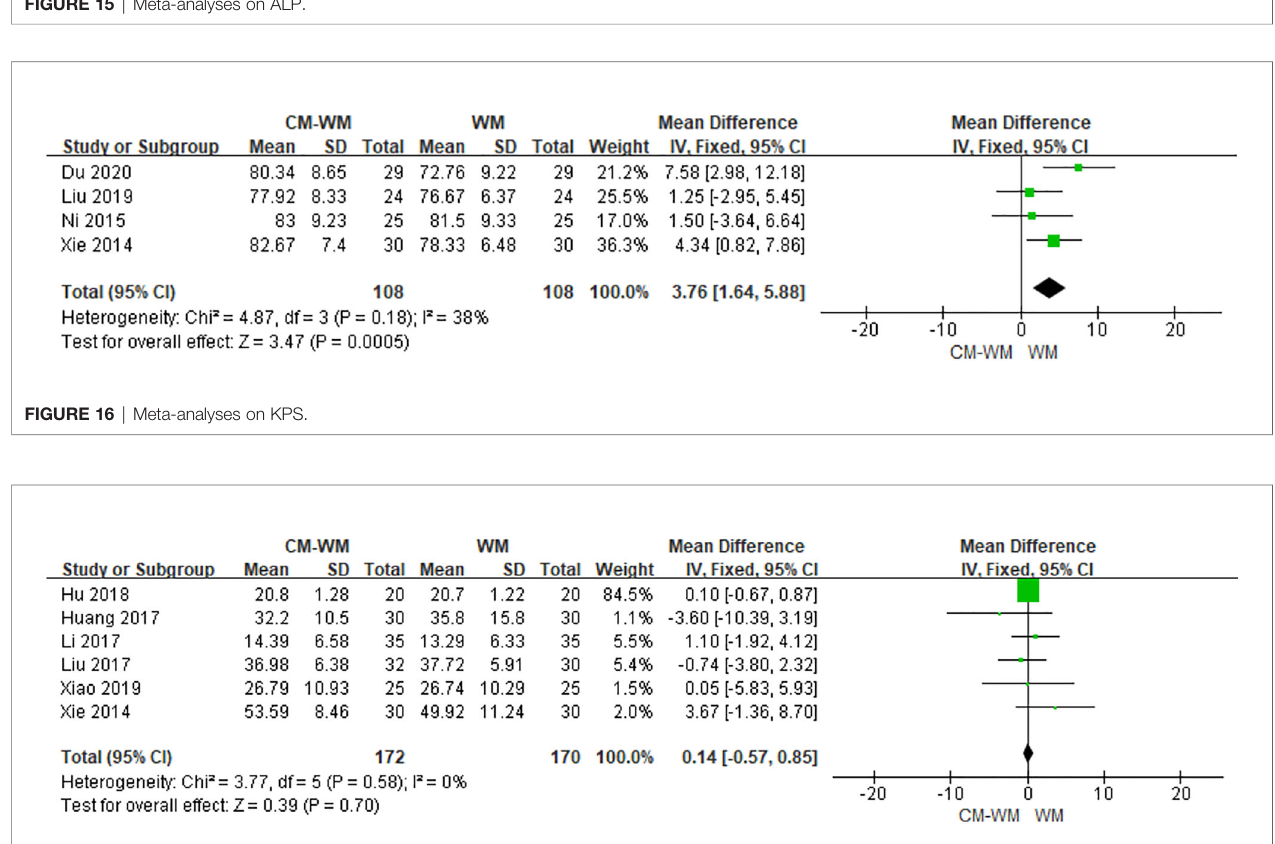
FIGURE 17 | Meta-analyses on E